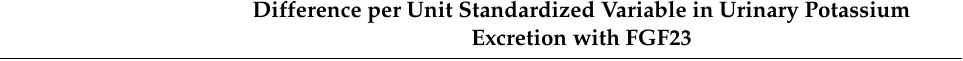
Table 2. Multivariable associations between urinary potassium excretion and (log 2 ) fibroblast growth factor 23 in 4194 participants of the PREVEND cohort.